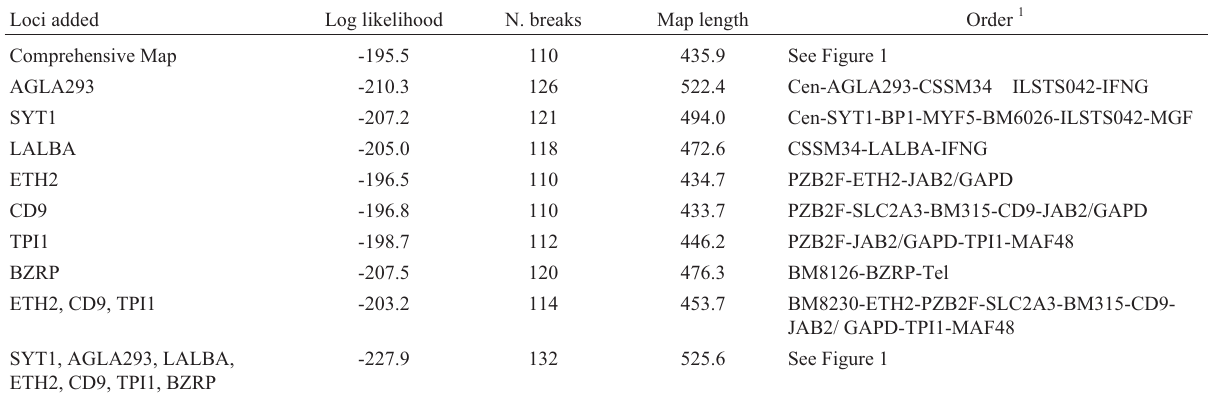
Table 5 - Analysis of the maps produced by adding markers scored by Barendse et al . (2000). Only the markers not scored in this study were used for this analysis. Loci added Log